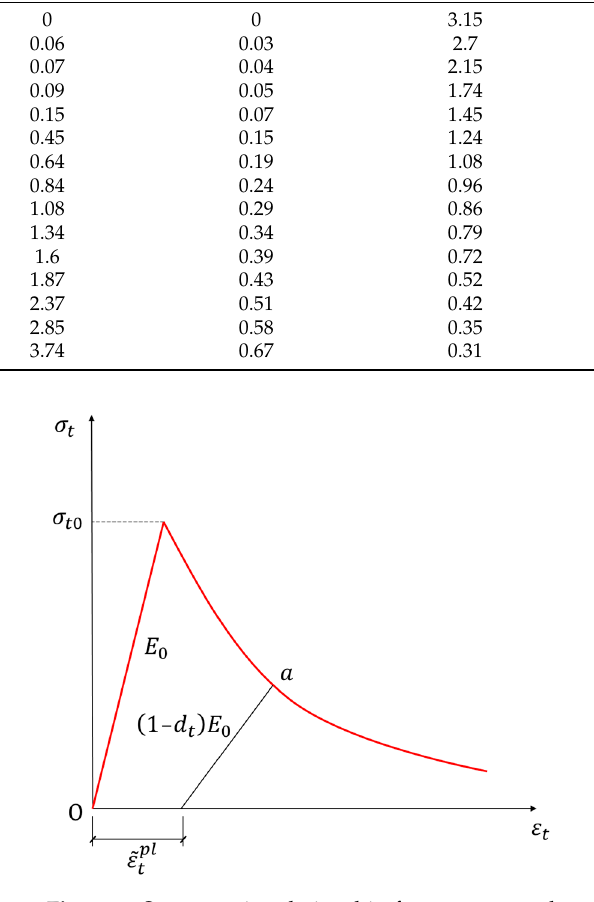
sion. 𝑑 (cid:3047) and 𝑑 (cid:3030) are the tensile and compressive damage factors in the concrete plastic damage model.